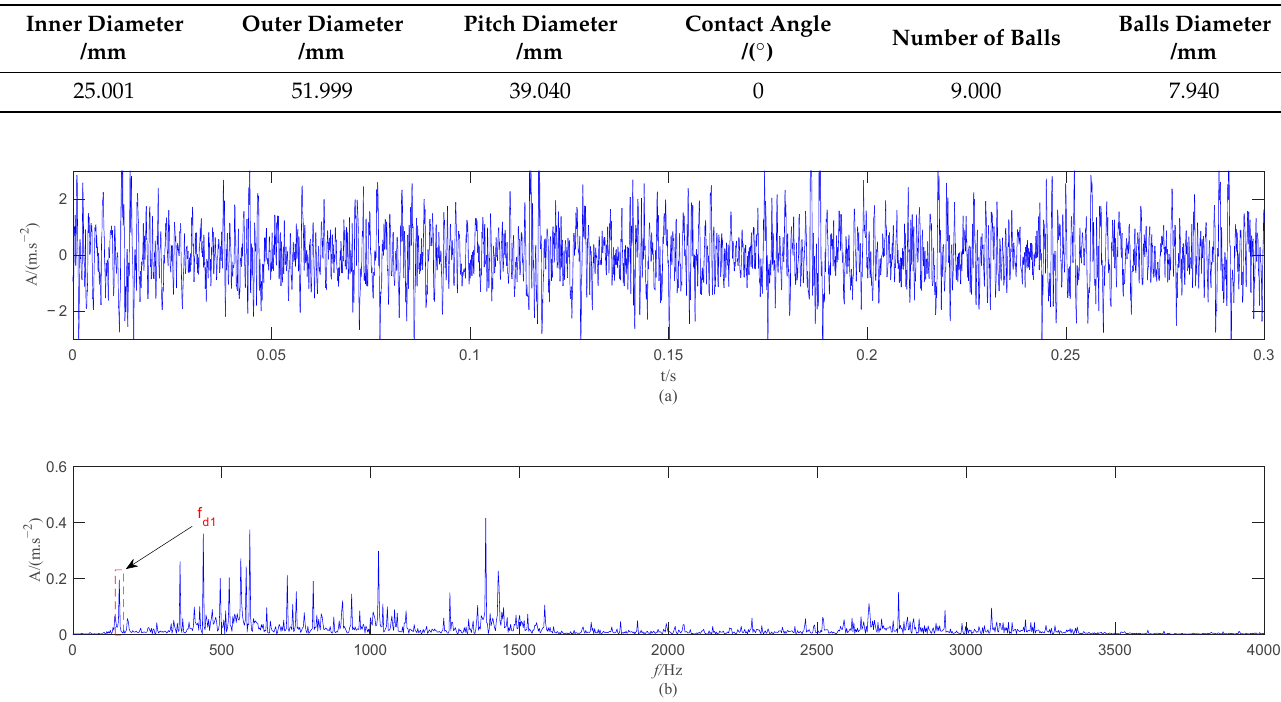
Figure 5. The experimental equipment. Table 1. Dimensions of the drive roller bearings.